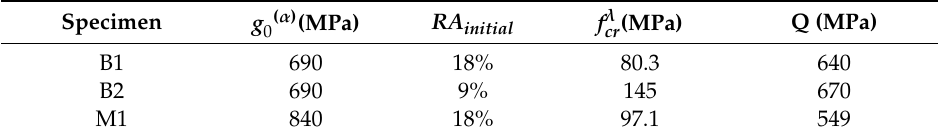
Table 4. Transformation plasticity and microplasticity